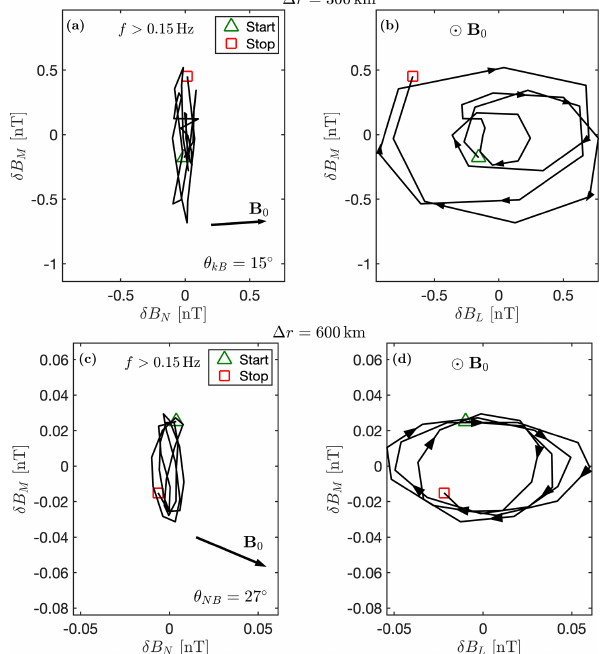
Figure 4. Hodographs of the magnetic field fluctuations. Panels (a) and (b) display the case of (cid:49)r = 300km, taken between t = 996 . 5s and t = 1013 . 5s. Panels (c) and (d) display the case (cid:49)r = 600km, taken between t = 910 . 0s and t = 928 . 0s. Panels (a) and (c) dis- play intermediate ( δB M ) and minimum ( δB N ) variance directions. An arrow marks the average background field B 0 . Panels (b) and (d) display intermediate ( δB M ) and maximum ( δB L ) variance direc- tions. Arrows show the time evolution of the fluctuations. A green triangle marks the start of the interval and a red square marks the